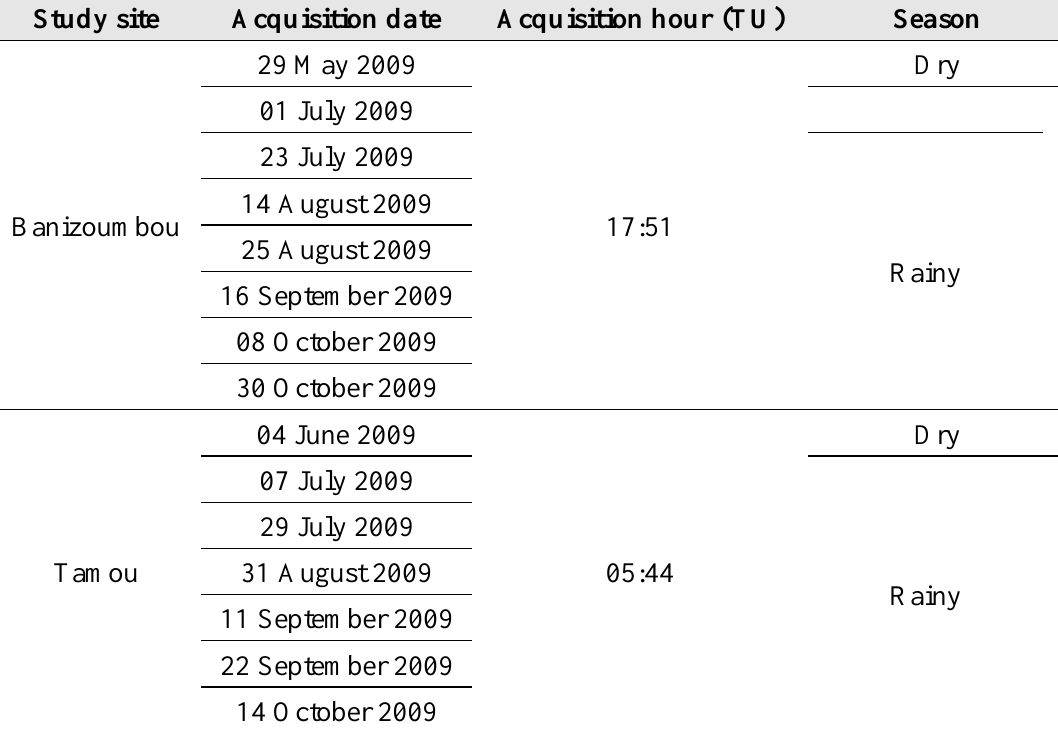
Table 1. List of TerraSAR-X images. Universal time (TU) = Local time − 1 hour. Study